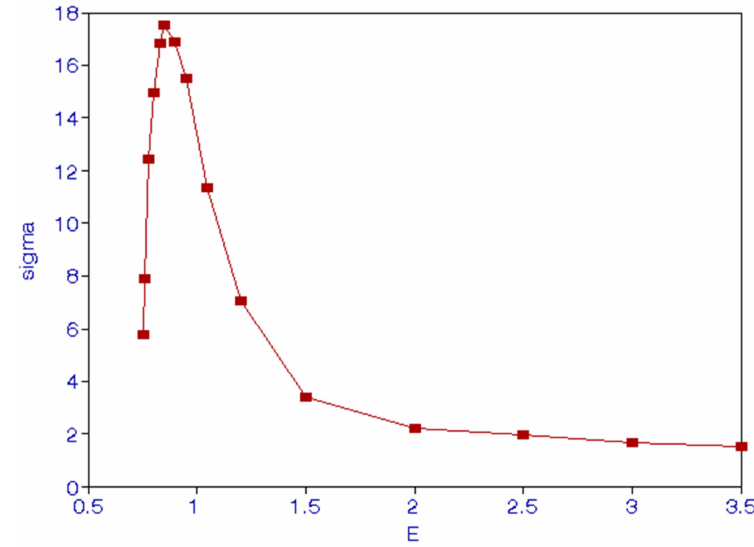
Figure 1. (Color online) Excitation cross sections ( a 2